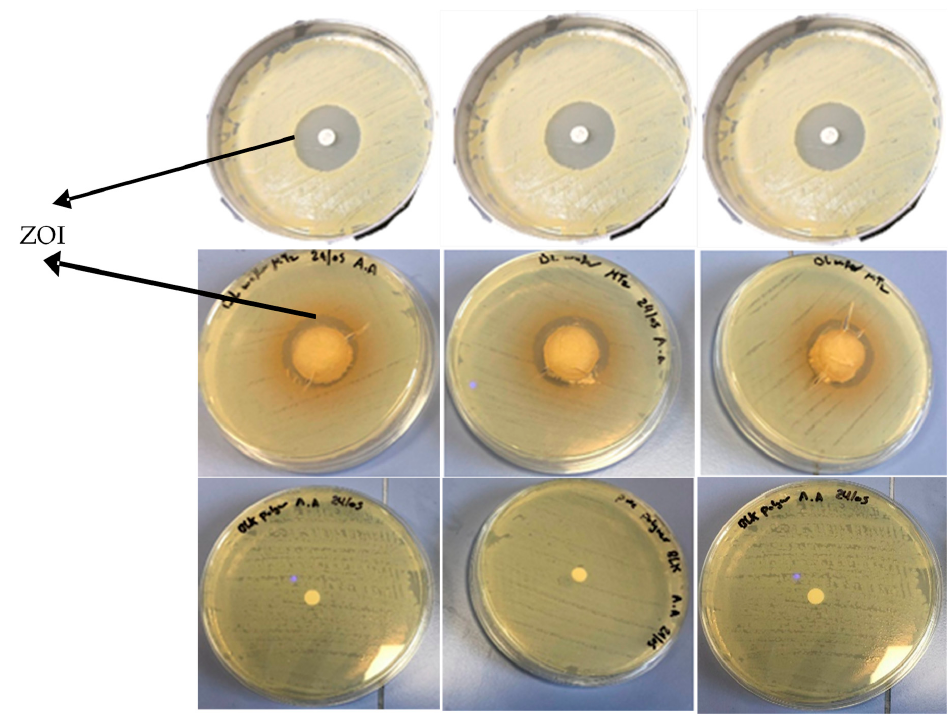
Figure 13. Zones of inhibition ( ZOI) of pure MTz as positive control ( top ), DL wafers ( middle ), and BLK wafers ( bottom ).